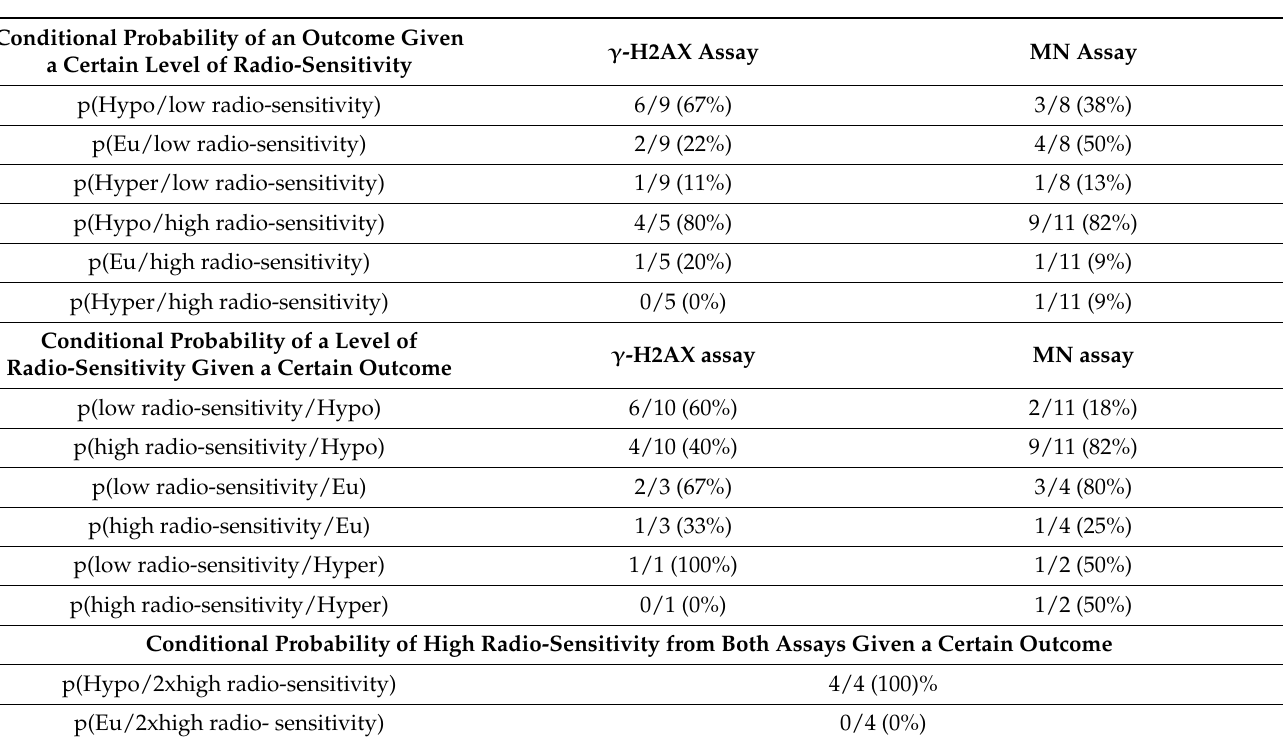
Table 3. Conditional probabilities relating the outcome to the level of radio-sensitivity before the